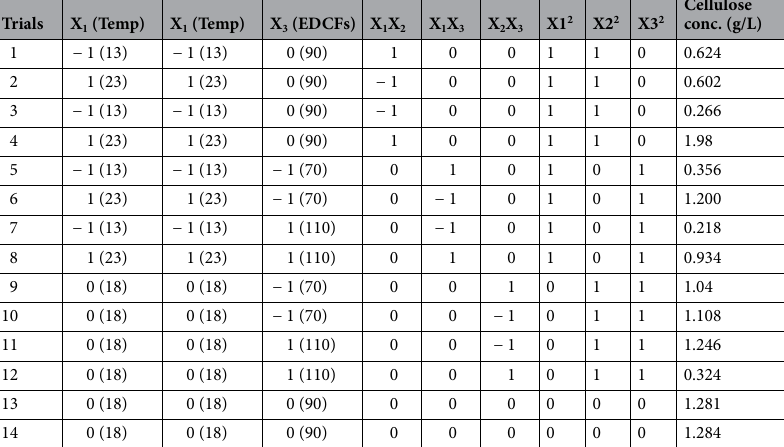
Table 2. BB experimental design for optimizing the most significant variables influencing on biocellulose concentration produced by Komagataeibacter hansenii AS.5 using EDCFs as a carbon and nitrogen